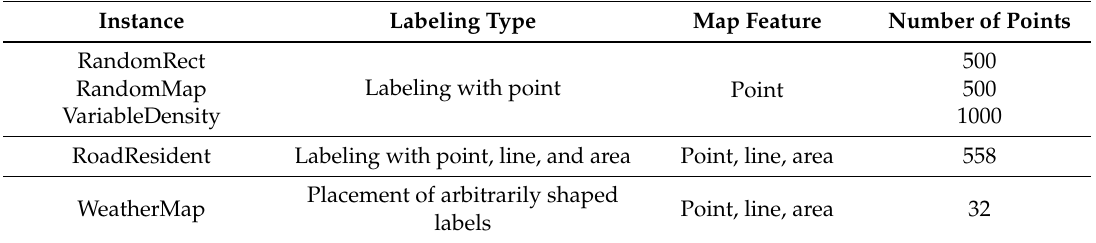
Table 3. Information of the instances for labeling